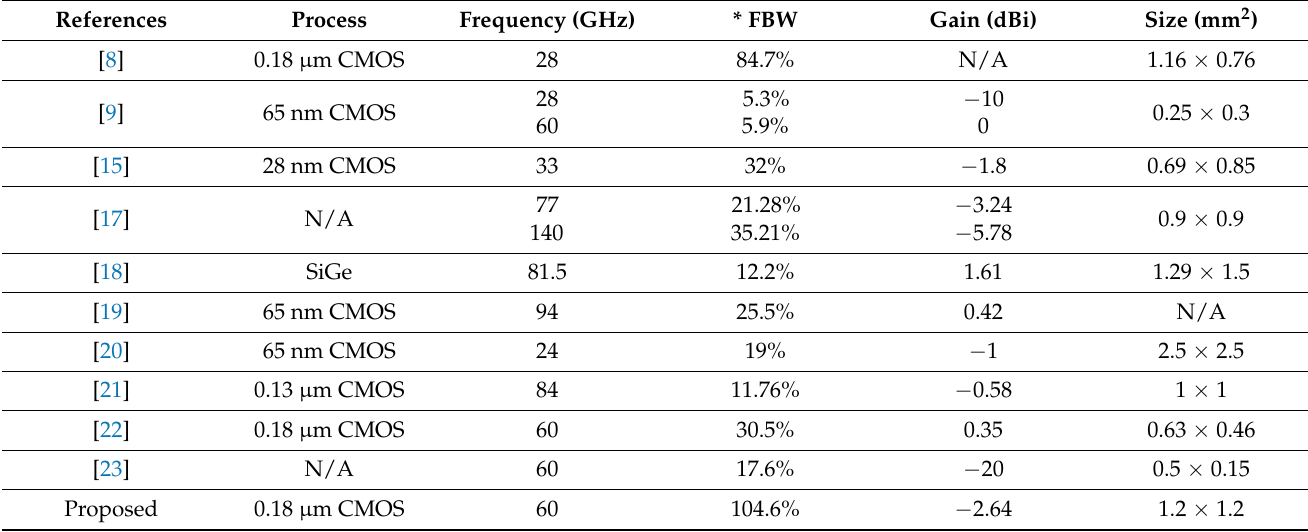
Table 4. Comparison of the proposed antenna with other research